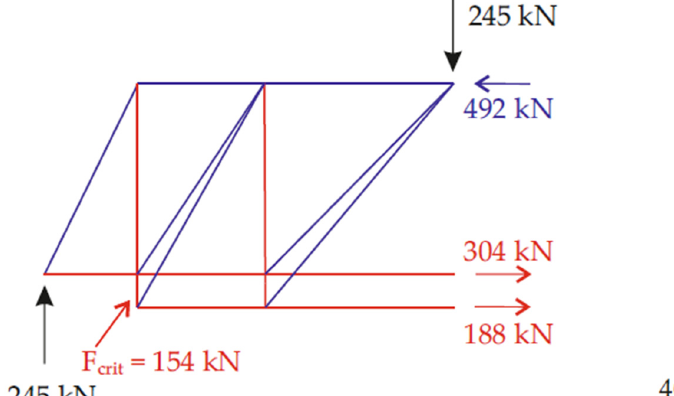
21 Figure 24. Final crack state and strut-and-tie-model for specimen 1. (Graphic: CARBOCON GMBH). Figure 25. Final crack state and strut-and-tie-model for specimen 2. (Graphic: CARBOCON GMBH). In Figure 26, the calculated loads of the most relevant struts at the moment of failure of both specimens are shown. One may assume that the difference of forces ∆ F in the critical tensile struts F crit between both specimens is carried by the dowels. As the